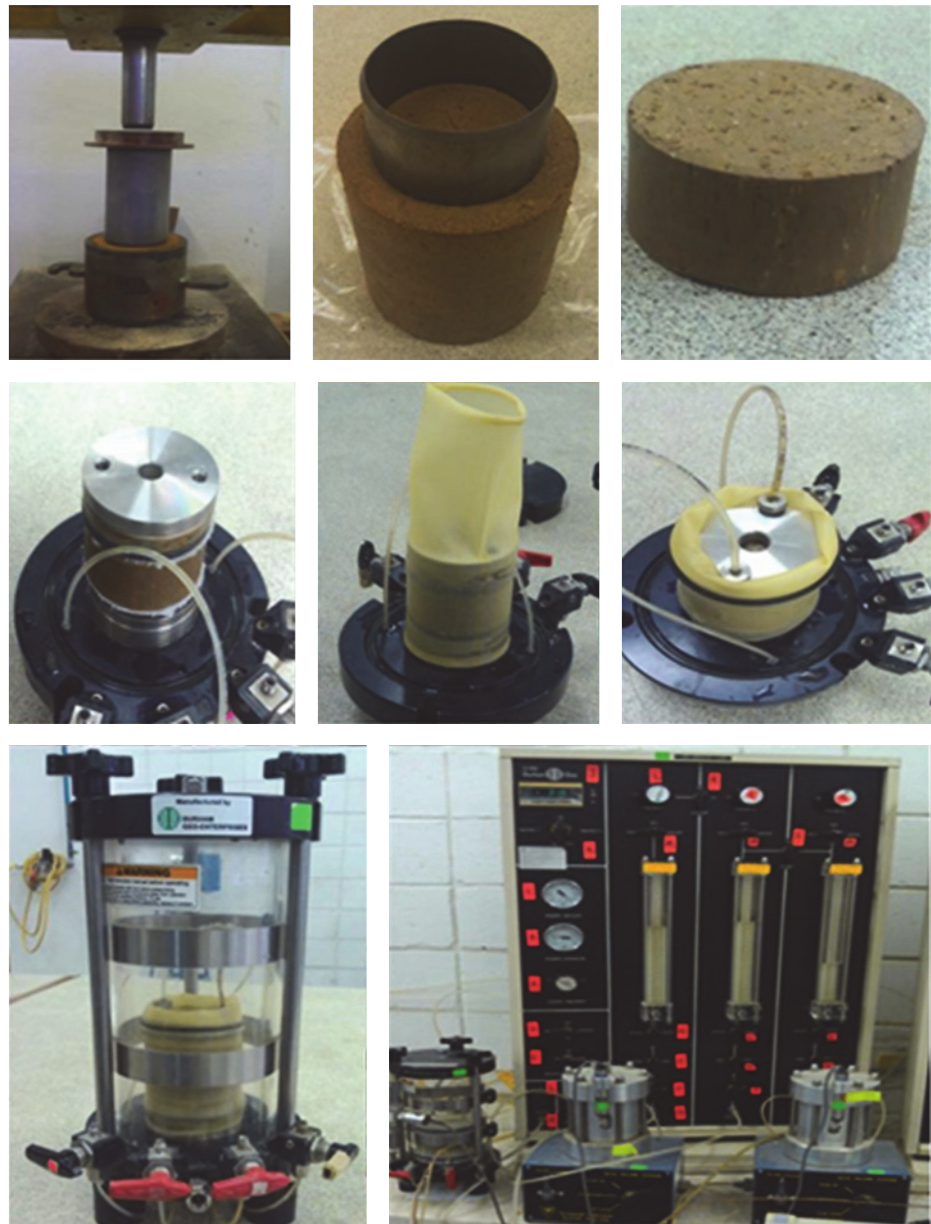
Figure 5: Sample preparation procedures for hydraulic conductivity test in flexible membrane